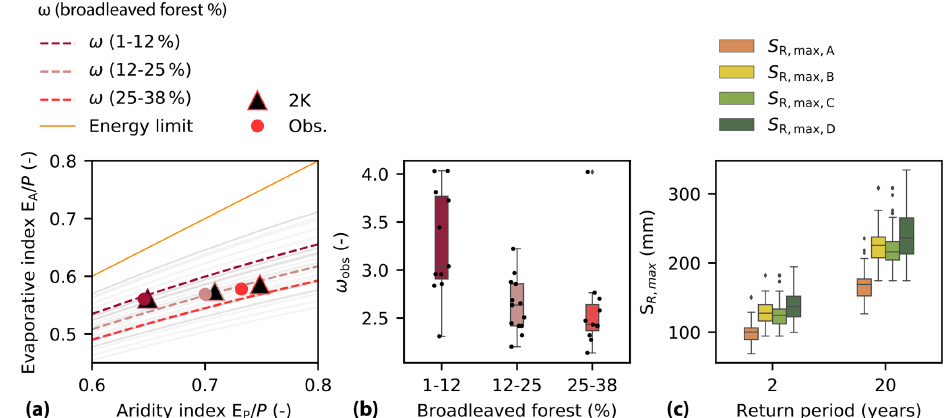
Figure 4. (a) Budyko space with parametric ω obs curves for each of the 35 catchments of the Meuse basin. The dashed curves represent the median ω obs curves for each category of areal broadleaved forest percentage. The change in the median aridity index across the catchments of the three categories, from historical to 2K climate conditions, is shown by the circles and triangles. (b) Parameterized ω obs values for each of the 35 catchments of the Meuse basin, categorized according to their percentage of broadleaved forest. (c) Range of root zone storage capacities across the 35 catchments of the Meuse basin for the four scenarios. S R , max , A represents the root zone storage capacity for historical conditions. S R , max , B represents an adapted root zone storage capacity in response to the 2K climate but no land use change. In the estimation of S R , max , C , catchments with a low percentage of broadleaved forest (1%–12%) receive ω values sampled from catchments with a high percentage of broadleaved forest (25%–38%) to represent changes in land use towards a conversion to broadleaved forest. The same, but reversed, approach is applied for the estimation of S R , max , D